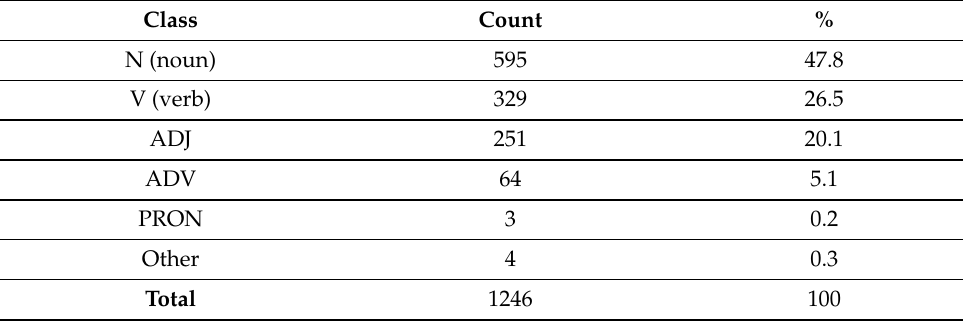
Table 3. Counts and proportions of lexicon entries for different lexical